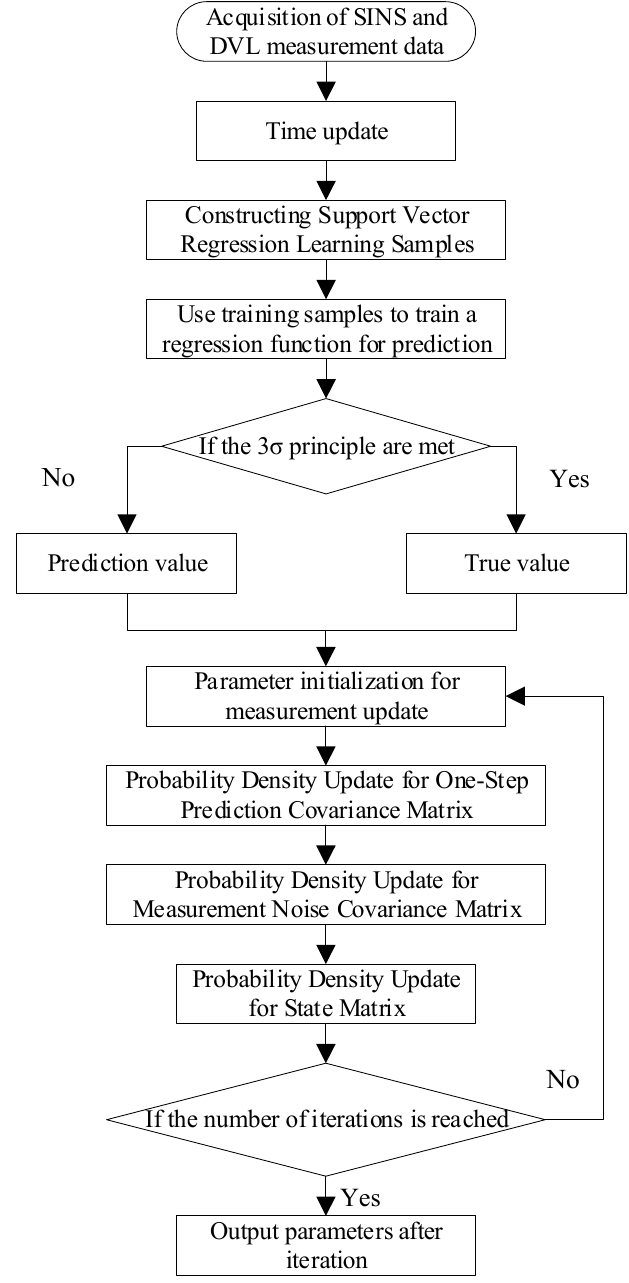
Figure 5. Process flow support vector regression assisted adaptive filter.